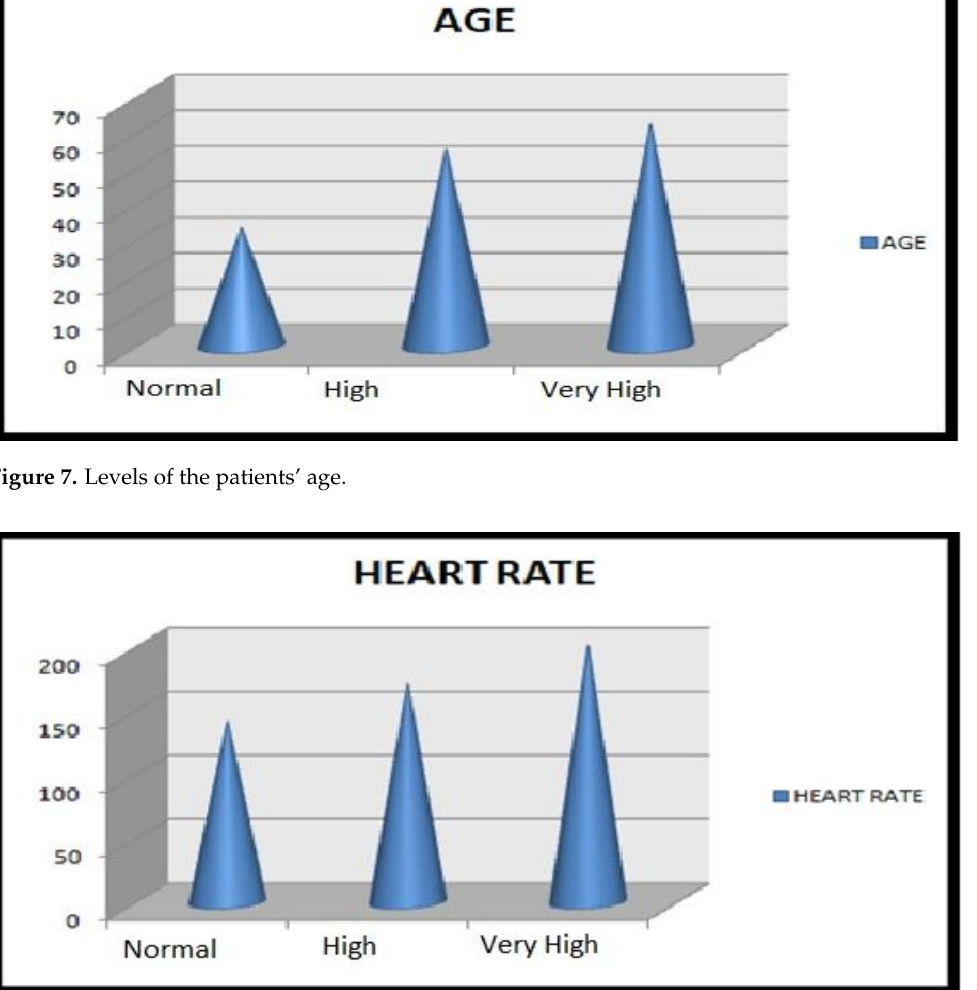
Figure 9. The levels of heart disease output. 4.1. Patient Selected for Diagnosis and Treatment At the Tehsil headquarters hospital Yazman District Bahawalpur, ten patients were randomly selected under the supervision of expert doctors for diagnosis and treatment. These patients kept in touch daily for routine checkups; random inputs from these were fed into the implemented system and results were taken according to the fuzzy rules that are implemented in the system using MATLAB, and then implemented into the applica- tion in visual C# language, after which results were taken again. All results of the diag- nosis of the patient and the fuzzy rules member function follow (Figures 10–13).